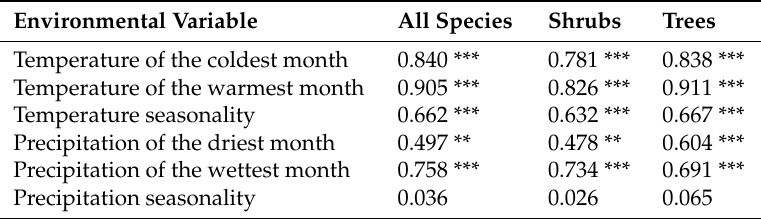
Table 2. Explanatory powers ( R 2 ) of climatic variables with species richness for all species, and